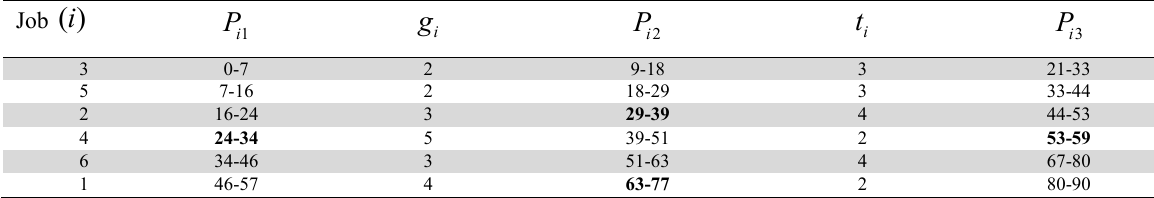
Total elapsed time with the absence of